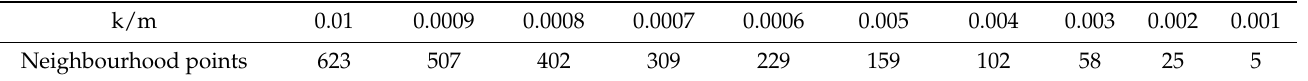
Table 1. The average number of neighbourhood points under different values of k .